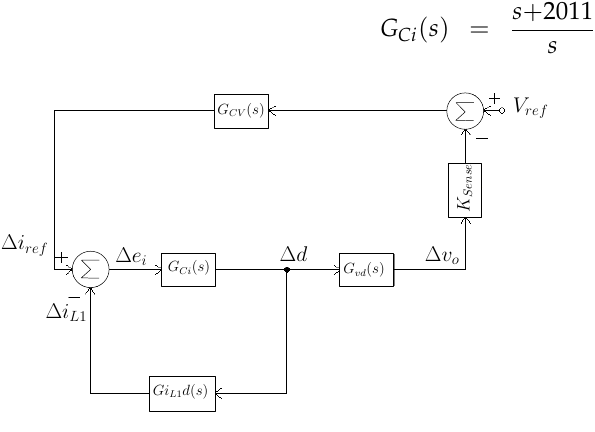
Figure 13. System block diagram of the small signal model.